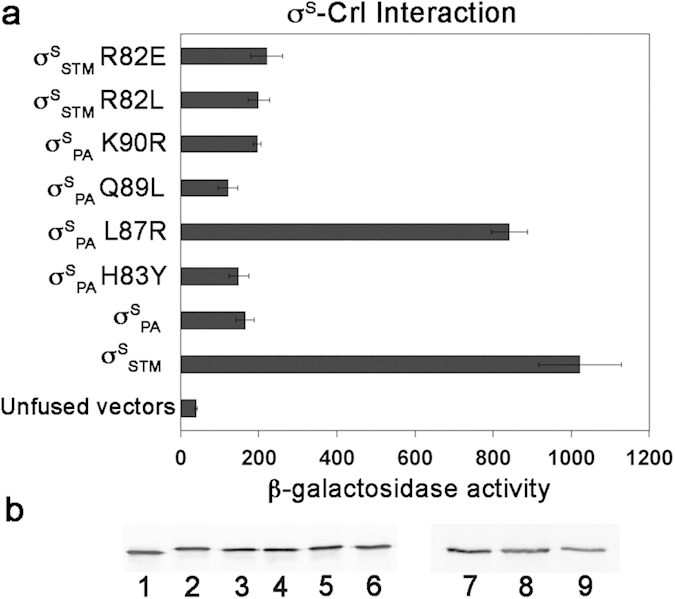
BACTH interaction analyses between Crl from S. Typhimurium and σS wild-type and variant proteins from S. Typhimurium and P. aeruginosa.(a) Interaction between CrlSTM-T18 and the T25-σS hybrid proteins indicated was quantified by measuring β-galactosidase activity in Miller units. Results are the mean of at least three independent experiments and standard deviations are indicated with black bars. (b) Immunodetection of T25-σS fusion proteins by antibodies directed against the T25 polypeptide. Lane 1, σSSTM; lane 2, σSPA; lane 3, σSPA H83Y; lane 4, σSPA L87R; lane 5, σSPA Q89L; lane 6, σSPA K90R; lane 7, σSSTM; lane 8, σSSTM R82L; lane 9, σSSTM R82E.